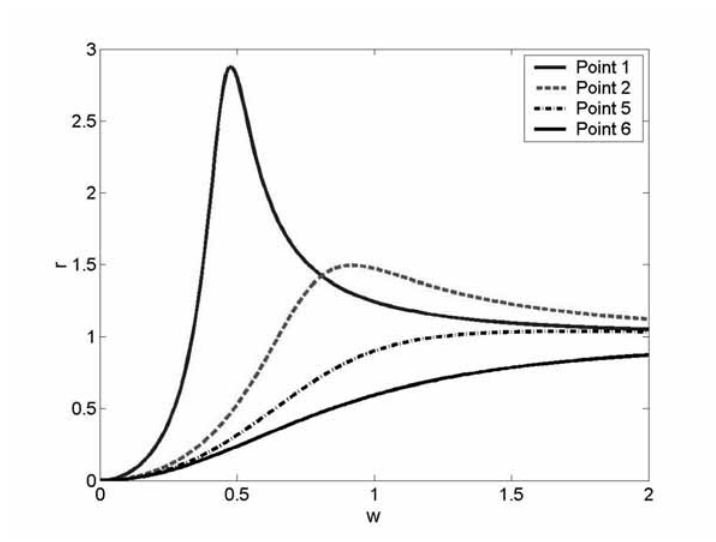
Fig. 28. Optimized relative displacement frequency